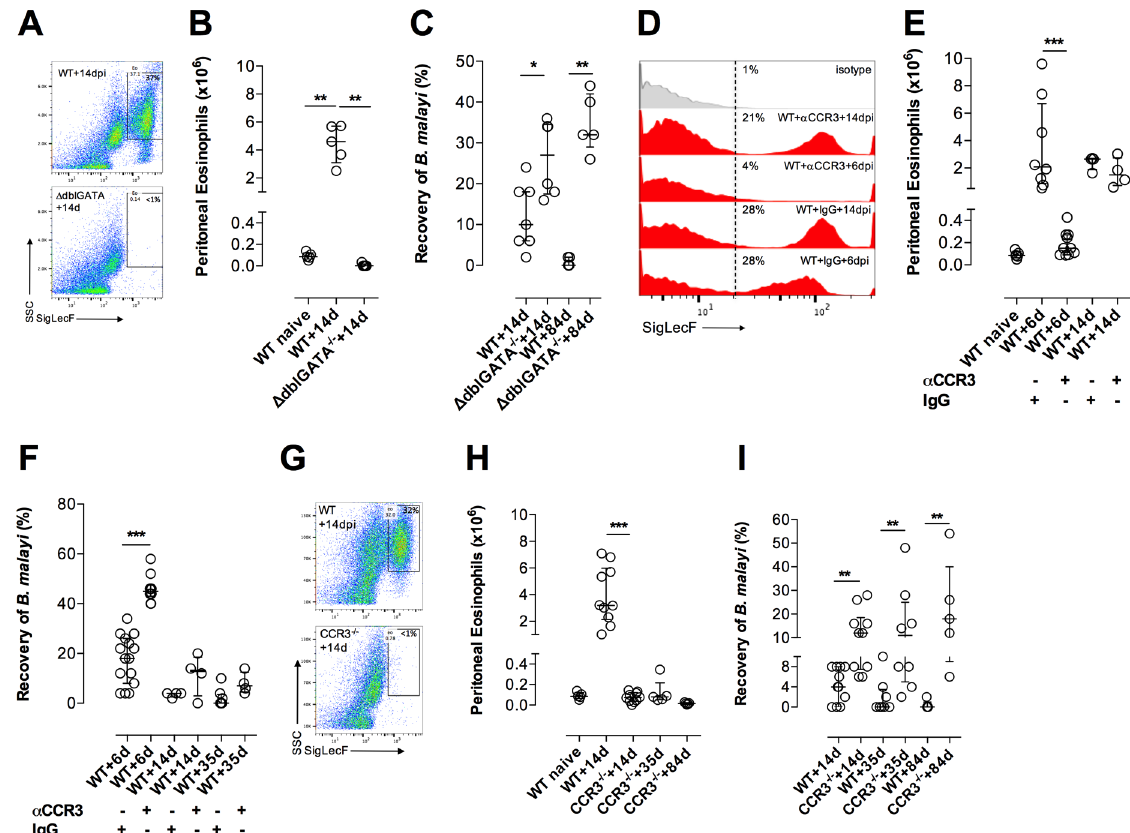
Fig 1. CCR3-dependent tissue eosinophilia is required for immunity to B . malayi . Enumeration of peritoneal eosinophils (A,B,D,E,G,H) and % recoveries of motile B . malayi in BALB/c WT compared with Δ dblGATA deficient mice (C) , in BALB/c WT mice treated with intraperitoneal (ip) rat IgG control or rat anti-CCR3 ( α CCR3) (F) or in WT compared with CCR3 deficient mice (I) at indicated time points post-ip infection with 50 Bm L3. Data from individual mice with median and interquartile range are plotted. Significant differences between na ï ve or infected WT controls and experimental groups at a given time point is assessed by Mann-Whitney or Kruskal-Wallis + Dunn’s tests ( > 2 groups). Data is plotted is either pooled from 2 individual experiments per time-point or from individual experiments with groups of 4–6 mice per group per